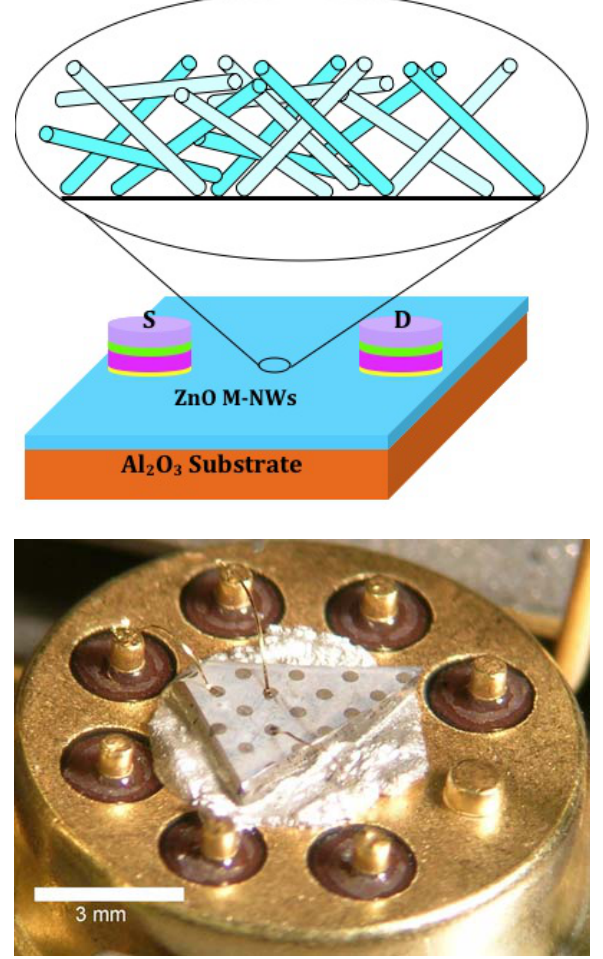
Figure 2. Schematic of contact geometry for multiple nanorod gas sensor (top) and packaged, wire-bonded device for testing